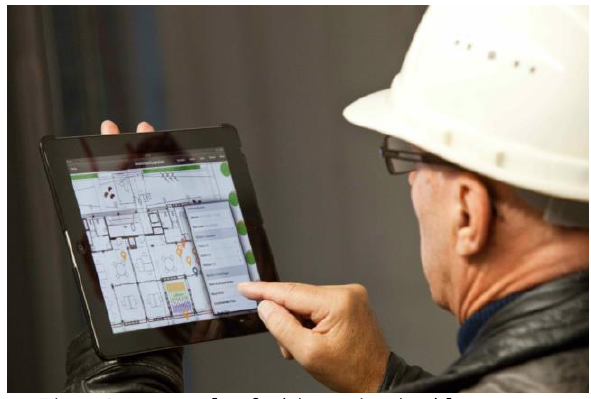
Figure 6. Docu-tools® feed-in on-site via tablet